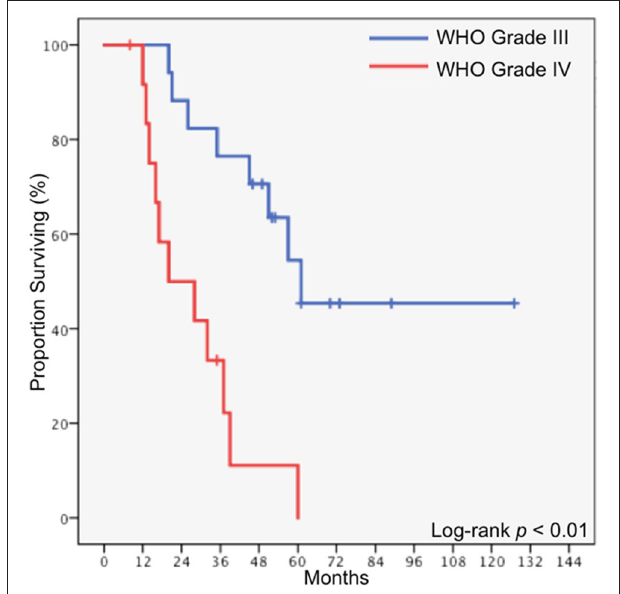
FIGURE 1 | Overall survival for the entire cohort. FIGURE 2 | Overall survival stratified by histology.